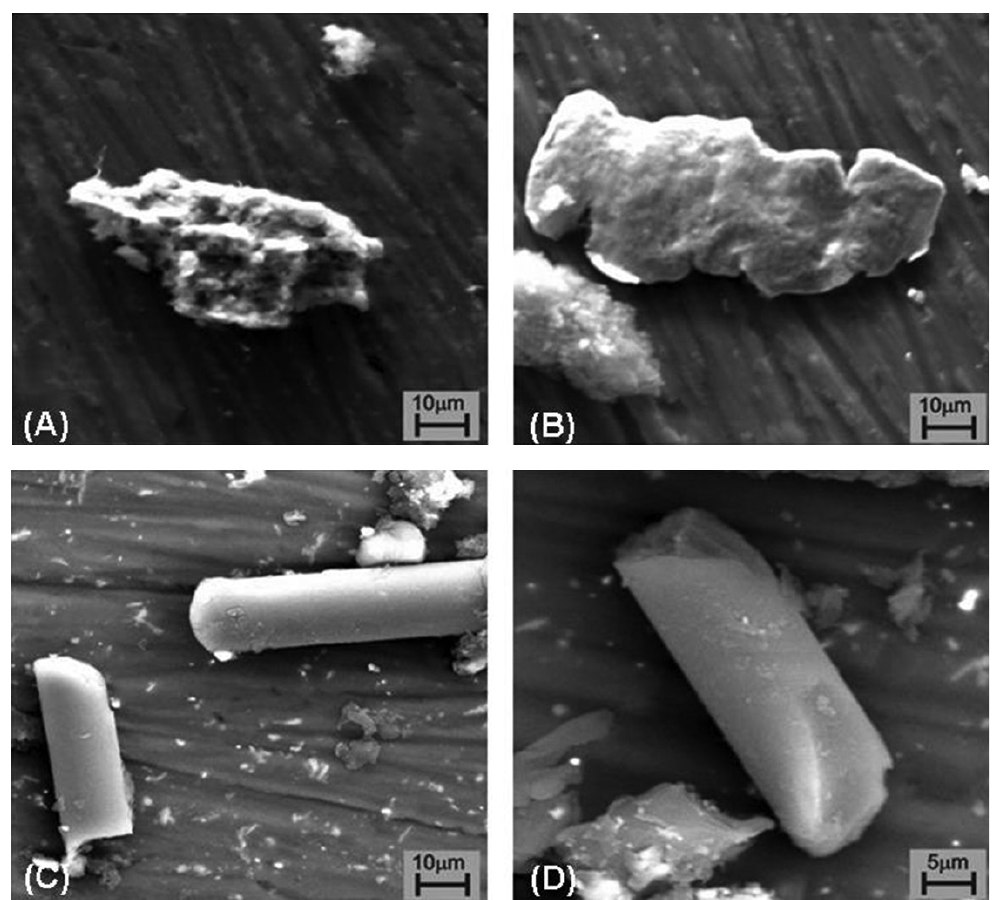
Figure 2. SEM of grinding dust (scattered morphology).